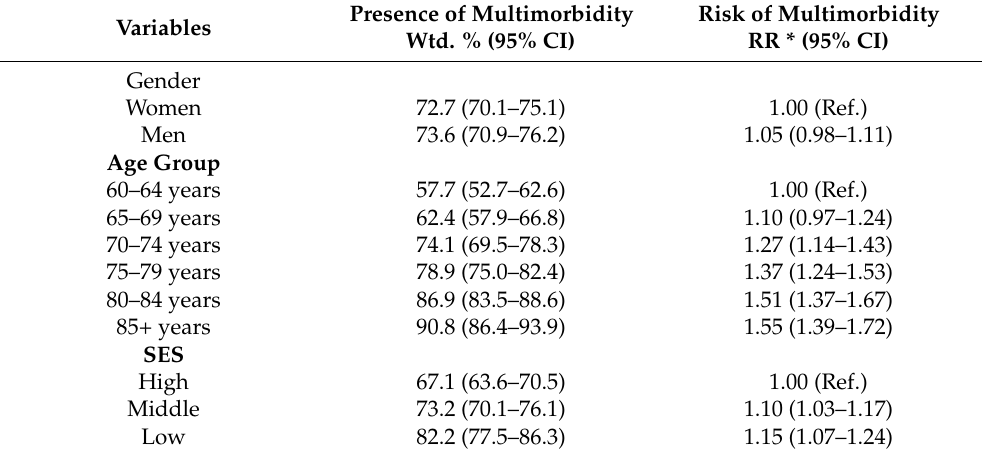
Table 5. Risk of multimorbidity.